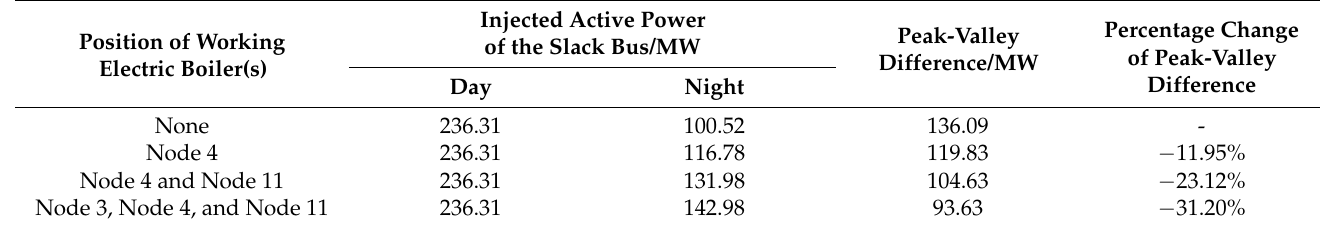
Table 6. Comparison of the results when putting electric boilers into